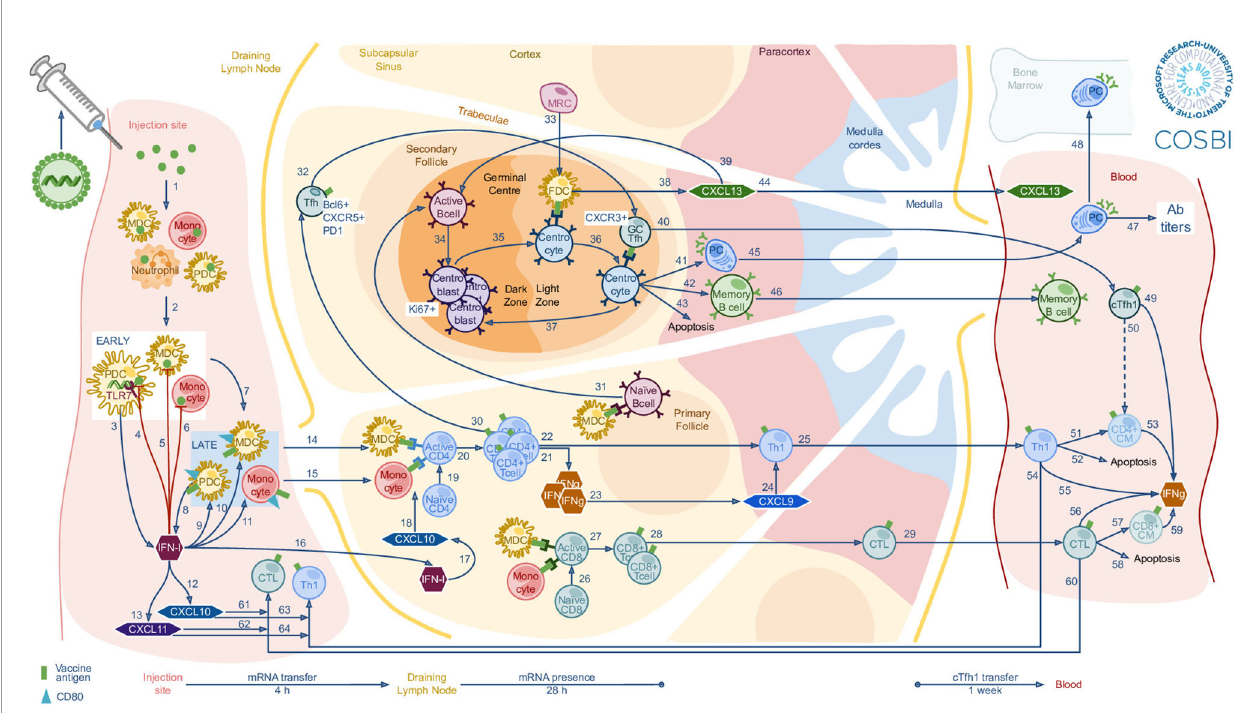
FIGURE 2 | Mechanistic graphical model of the mRNA-based vaccine biological mechanism of action. Lipid nanoparticles encapsulating mRNA molecules are intradermal or intramuscular injected triggering immune signals that reach the draining lymph node, where other immune reactions generate the speci fi c antibodies, eventually transferred into the circulatory system. This fi gure is proposed in a dynamic view at the link https://www.cosbi.eu/fx/9839203, where each connection (blue arrows) is documented by literature references as well as the involved cells measured in mouse and NHP